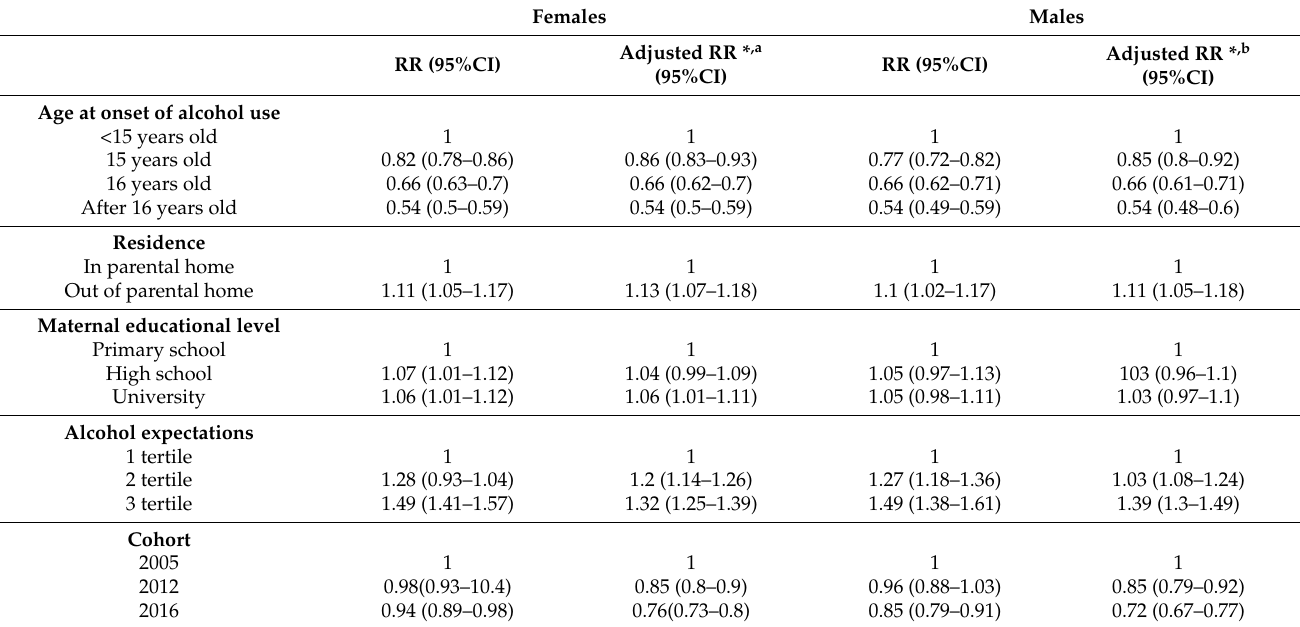
Table 3. Influence of explanatory factors in first domain (risky alcohol consumption) of AUDIT test score by gender. Negative binomial